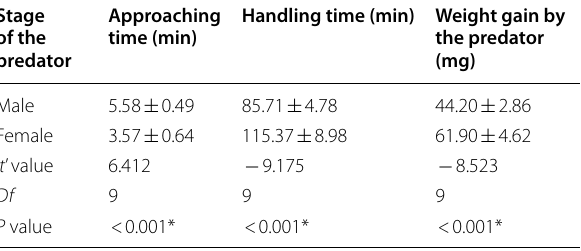
*Significantly different